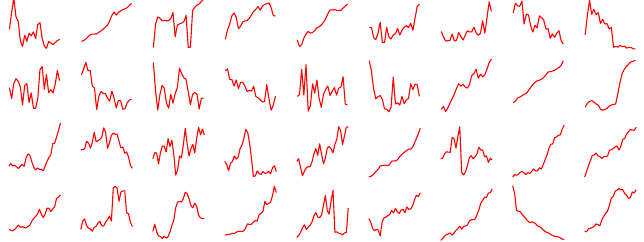
Figure 7. Eighteen actual yearly M4 series and eighteen simulated series.